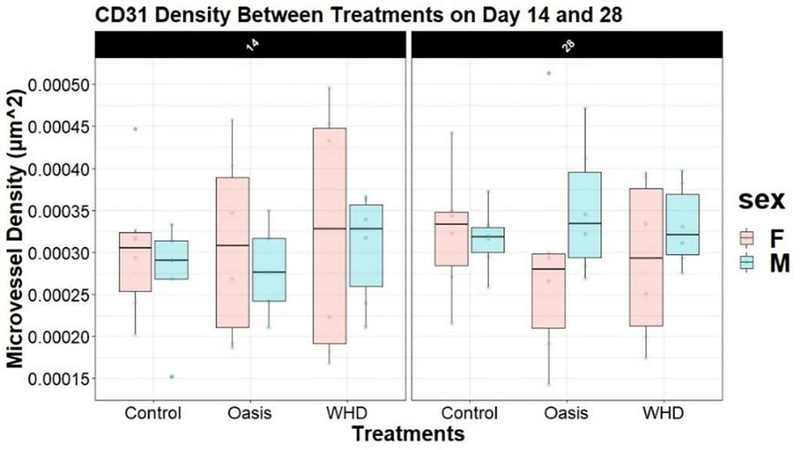
Microvessel density (CD31) faceted by day, treatment, and sex.